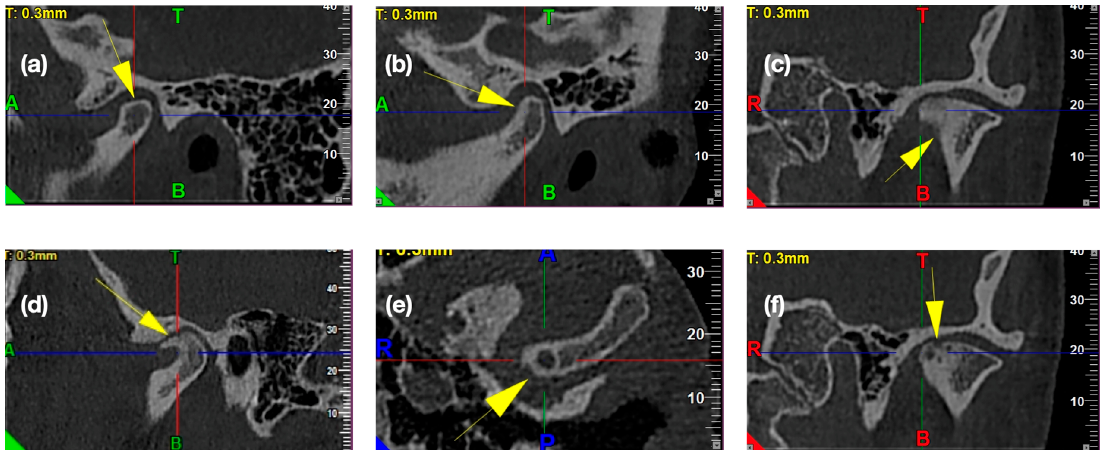
Figure 6. Osteoarthritic changes in the temporomandibular joints’ CBCT images: ( a ) Articular surface flattening, ( b ) subcortical sclerosis, ( c ) generalized sclerosis, ( d ) osteophyte, ( e ) subcortical cyst, and ( f ) erosion.